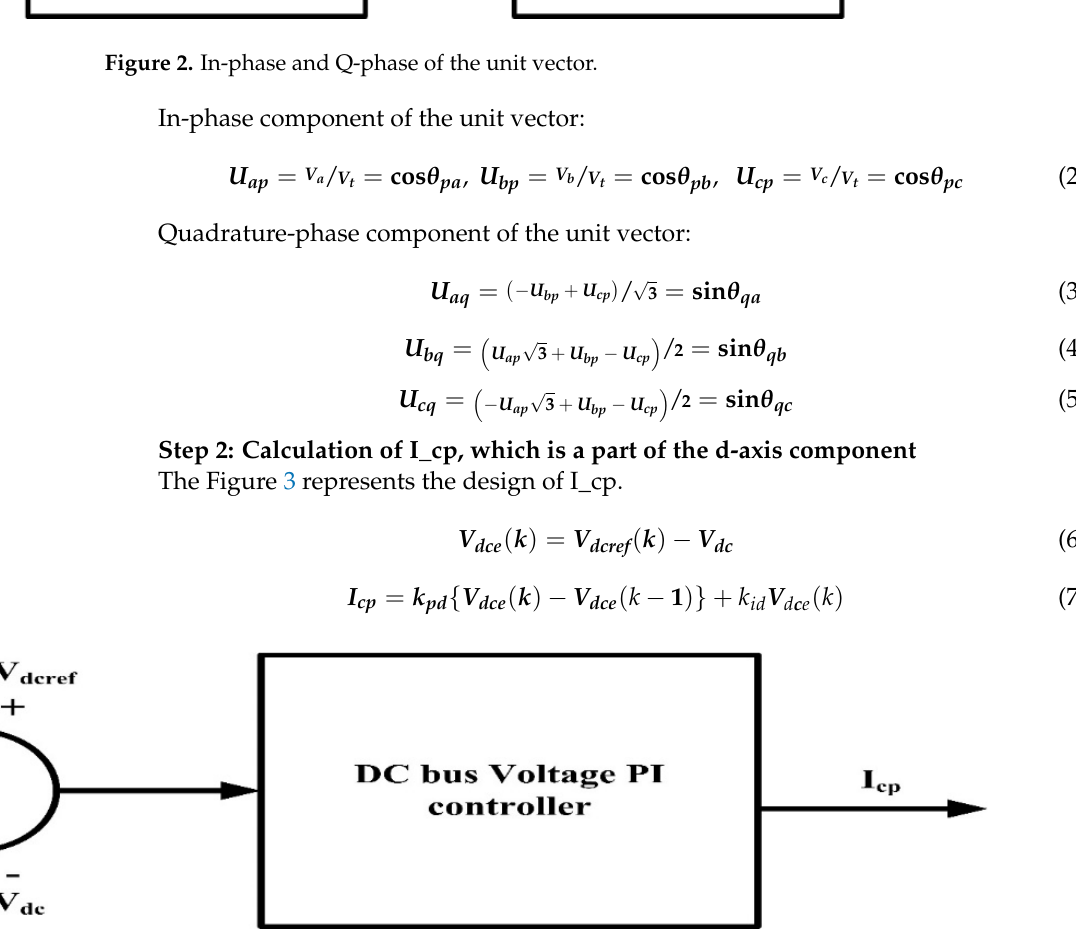
Figure 3. Design of I_cp.